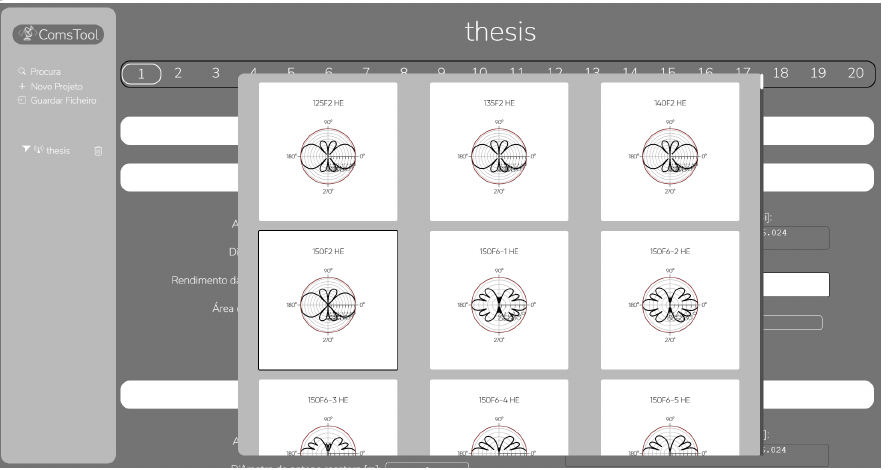
Figure 4. Radiation pattern